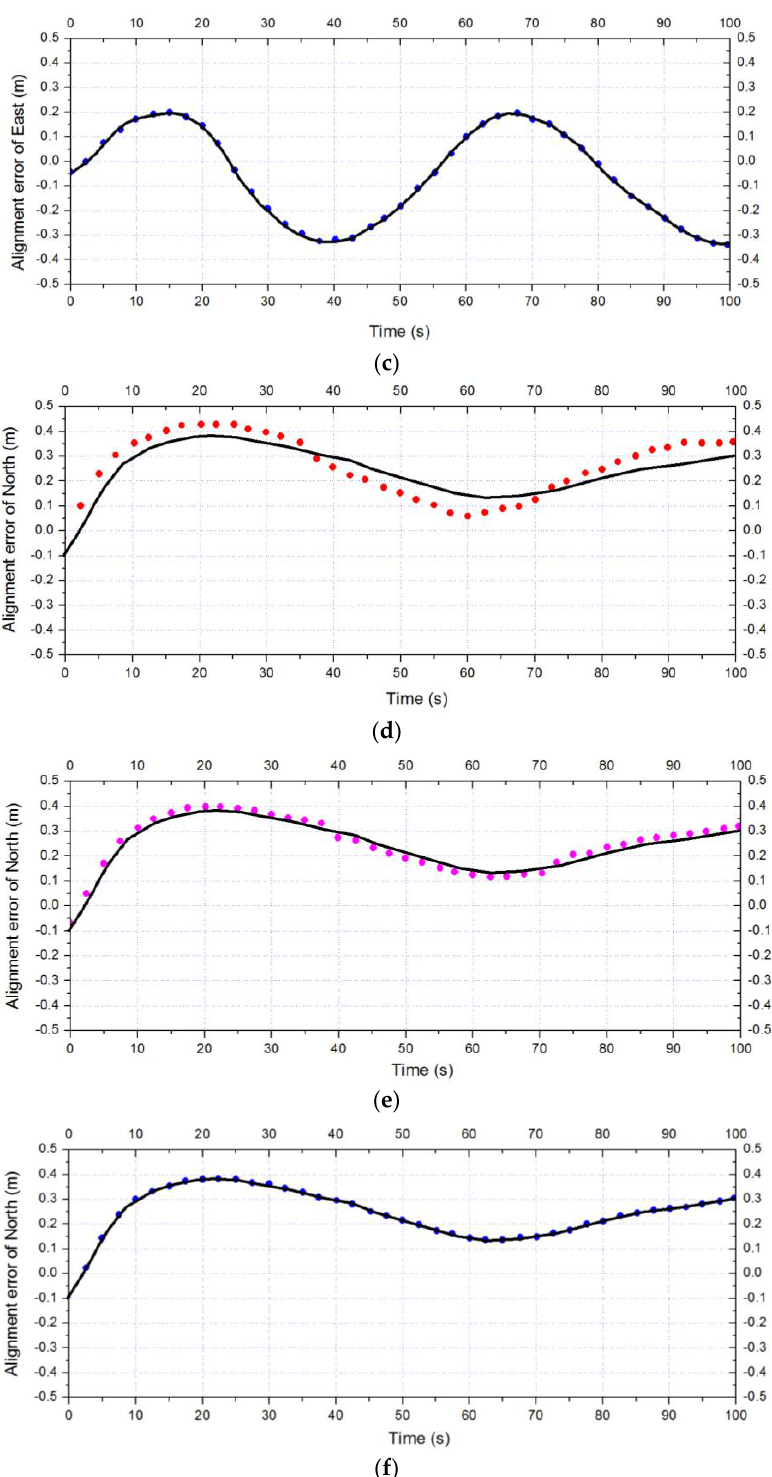
Figure 6 . Cont . Figure 6. Cont